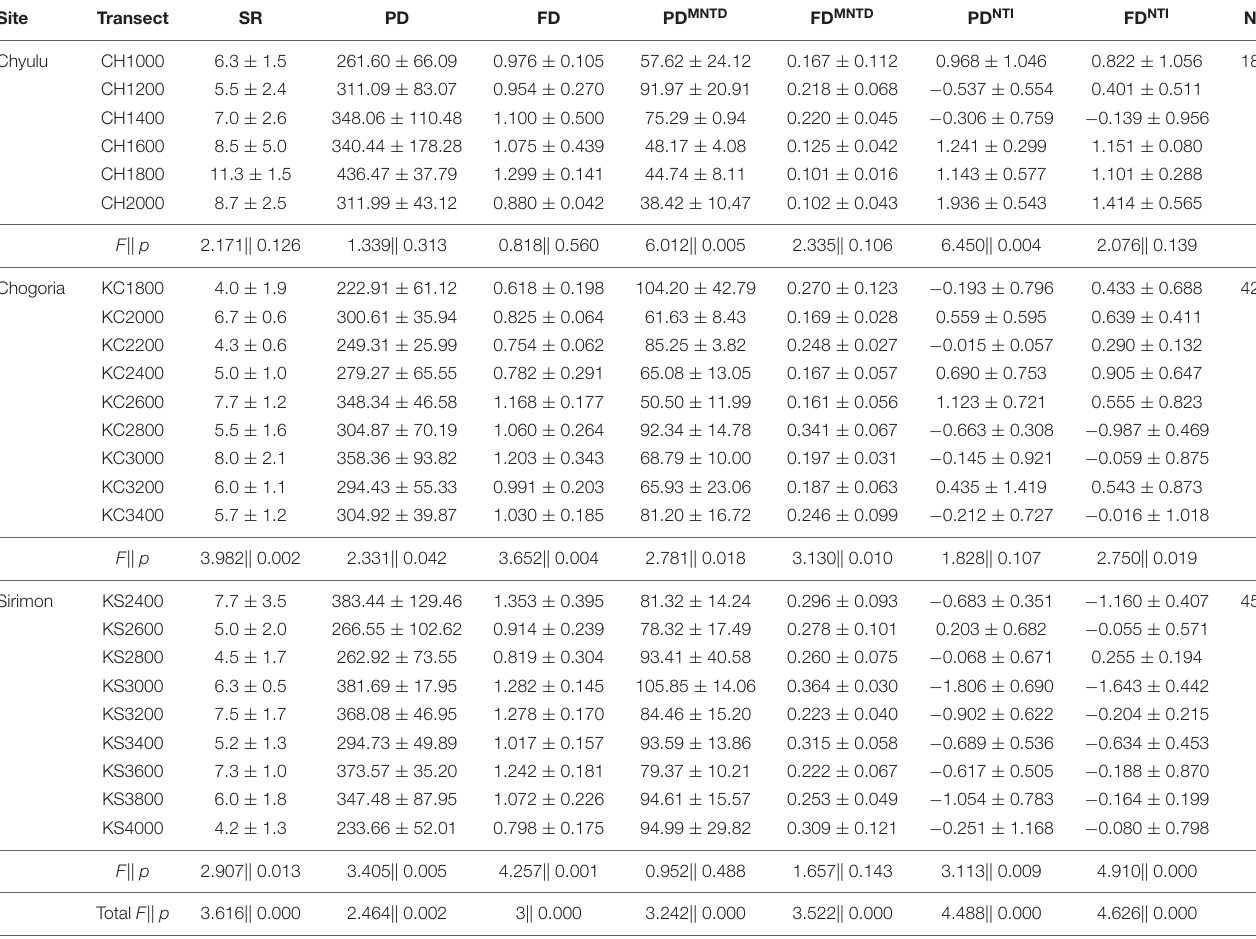
TABLE 2 | Summary statistics of diversity indices between the